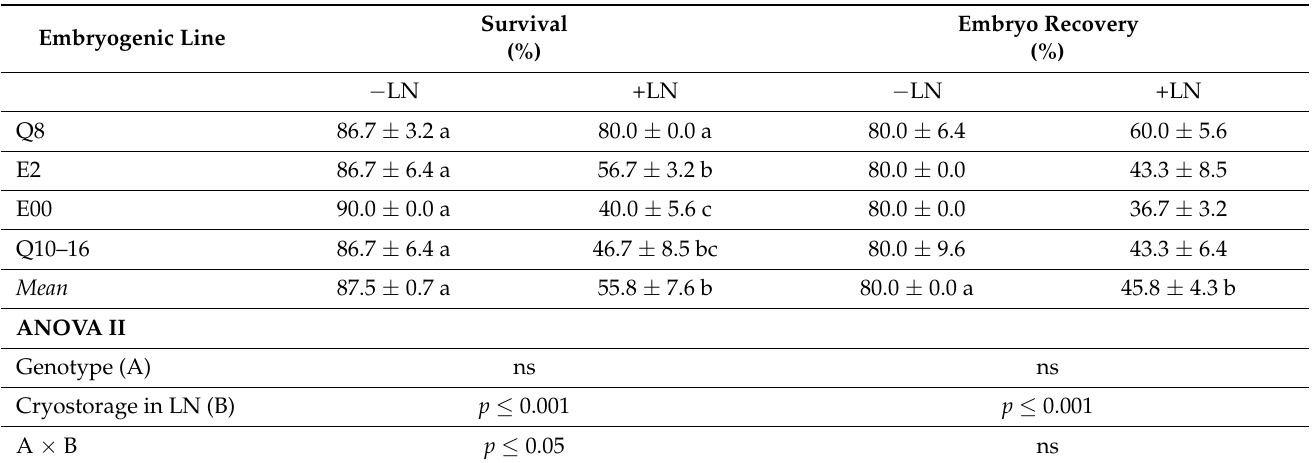
Table 3. Survival (%) and embryo recovery (%) of four holm oak embryogenic lines cryopreserved after preculture on medium containing sucrose and incubation in PVS2 solution for 15 min with (+LN) or without ( − LN) subsequent immersion in LN for one